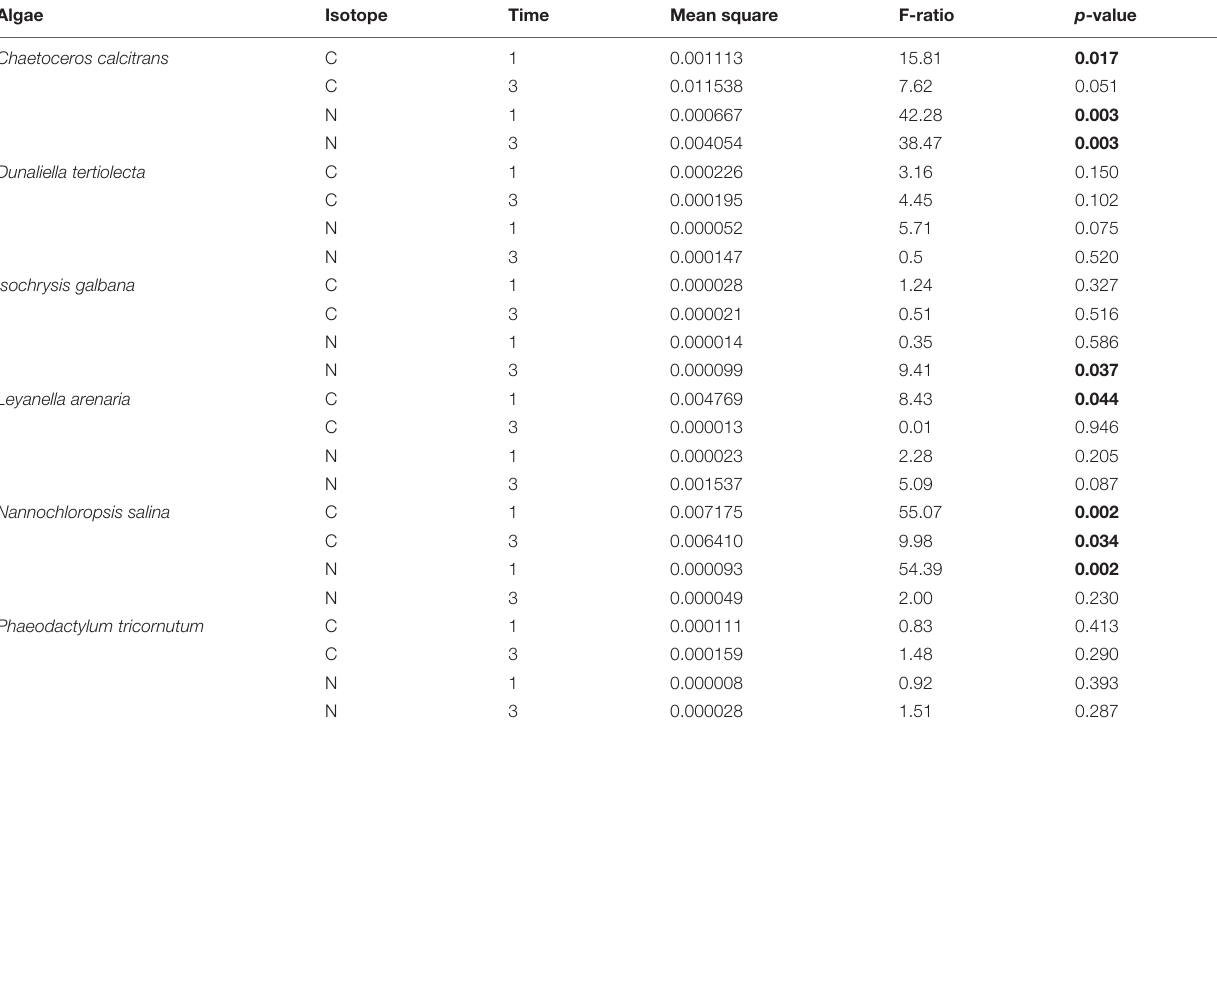
TABLE A2 | Statistical evaluation of the fresh vs. powder algae feeding experiments. Significant values are in bold.